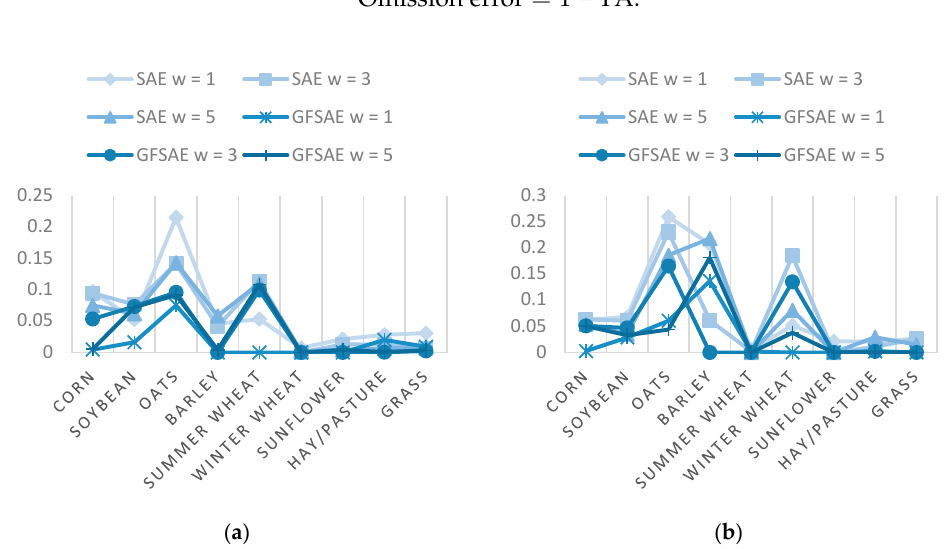
Figure 5. Omission ( a ) and Commission ( b ) errors of different crop types for the CEF dataset. The edge-aware filtering process is represented graphically in Figure 6. This figure shows the process for corn in the case of the w = 1 setting for the CEF dataset. Figure 6a shows the guidance image (G), (b) is the ground reference map for this class, (c) is the initial probability map for the class corn, i.e., P (1), (d) is the initial class map (i.e., the result of SAE), (e) is the probability map, P (1), after the guided filtering, and (f) is the final class map (i.e., the result of GFSAE). As we see, a more accurate map is obtained after the guided filtering process, removing isolated wrongly classified pixels from the class map.